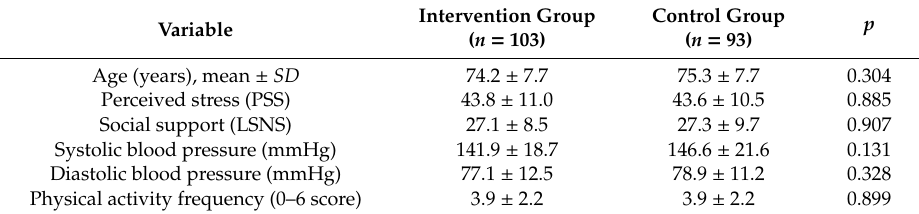
Table 1. Distribution of means for continuous variables by study group ( N = 196).